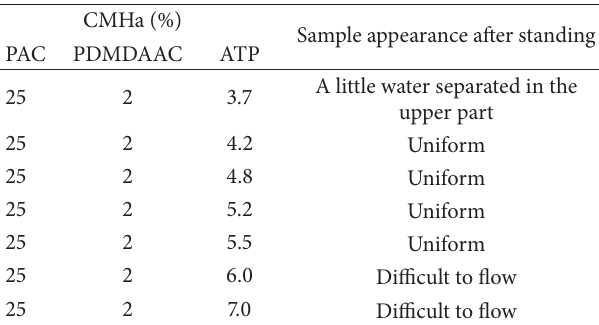
Table 3: The influence of attapulgite on the stability of CMHa. CMHa